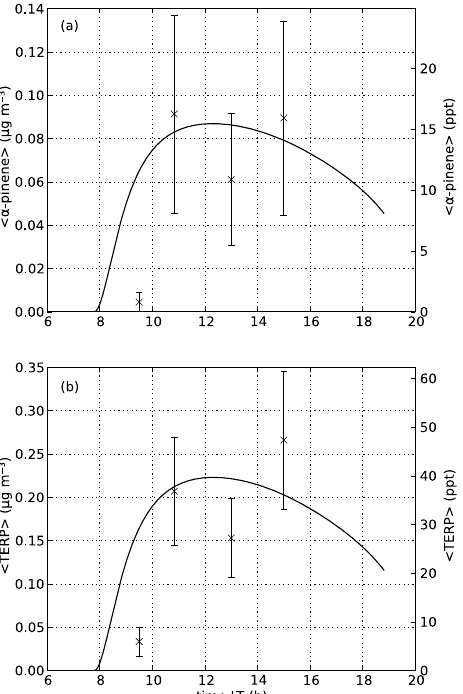
Fig. 5. (a) h α -pinene i and (b) sum of terpenes ( h TERP i ) for the case study. Crosses indicate balloon measurements and model re- sults are indicated by lines. Errors are 100% for concentrations lower than 0.03µgm − 3 , 50% for concentrations between 0.03 and 0.15µgm − 3 and 30% for concentrations higher than 0.15µgm − 3 . The conversion factor fromµgm − 3 toppt is 178.